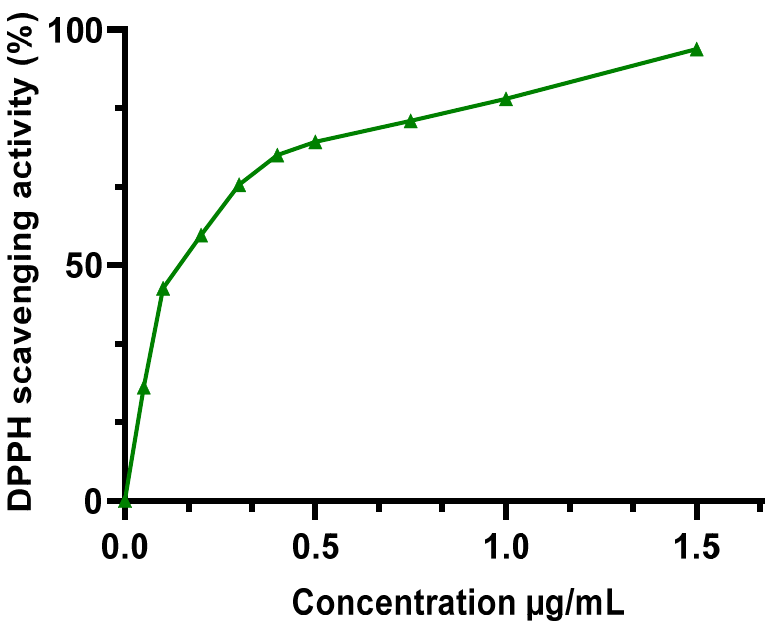
Figure 3. DPPH scavenging activity of BHT.